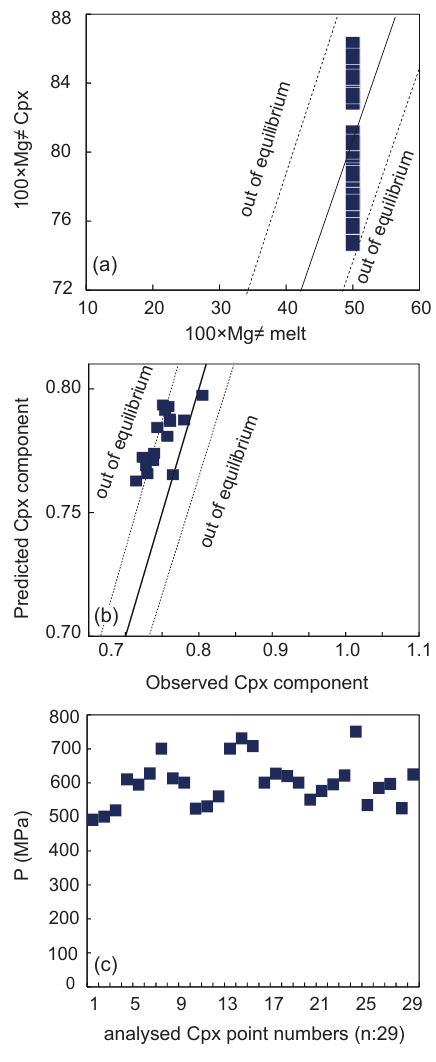
Figure 15. (a) Test for equilibrium using the Kd[FeMg] between clinopyroxene and nominal melt (basaltic andesite sample [no. N-1]). The result shows Kd[FeMg] values close to the ideal of 0.27 (Putirka, 2008). (b) Test for equilibrium using predicted vs. observed clinopyroxene components of diopside + hedenber- gite derived using the nominal equilibrium melt (basaltic an- desite dyke). Pressure calculated for selected clinopyroxene using clinopyroxene–melt barometry after Putirka